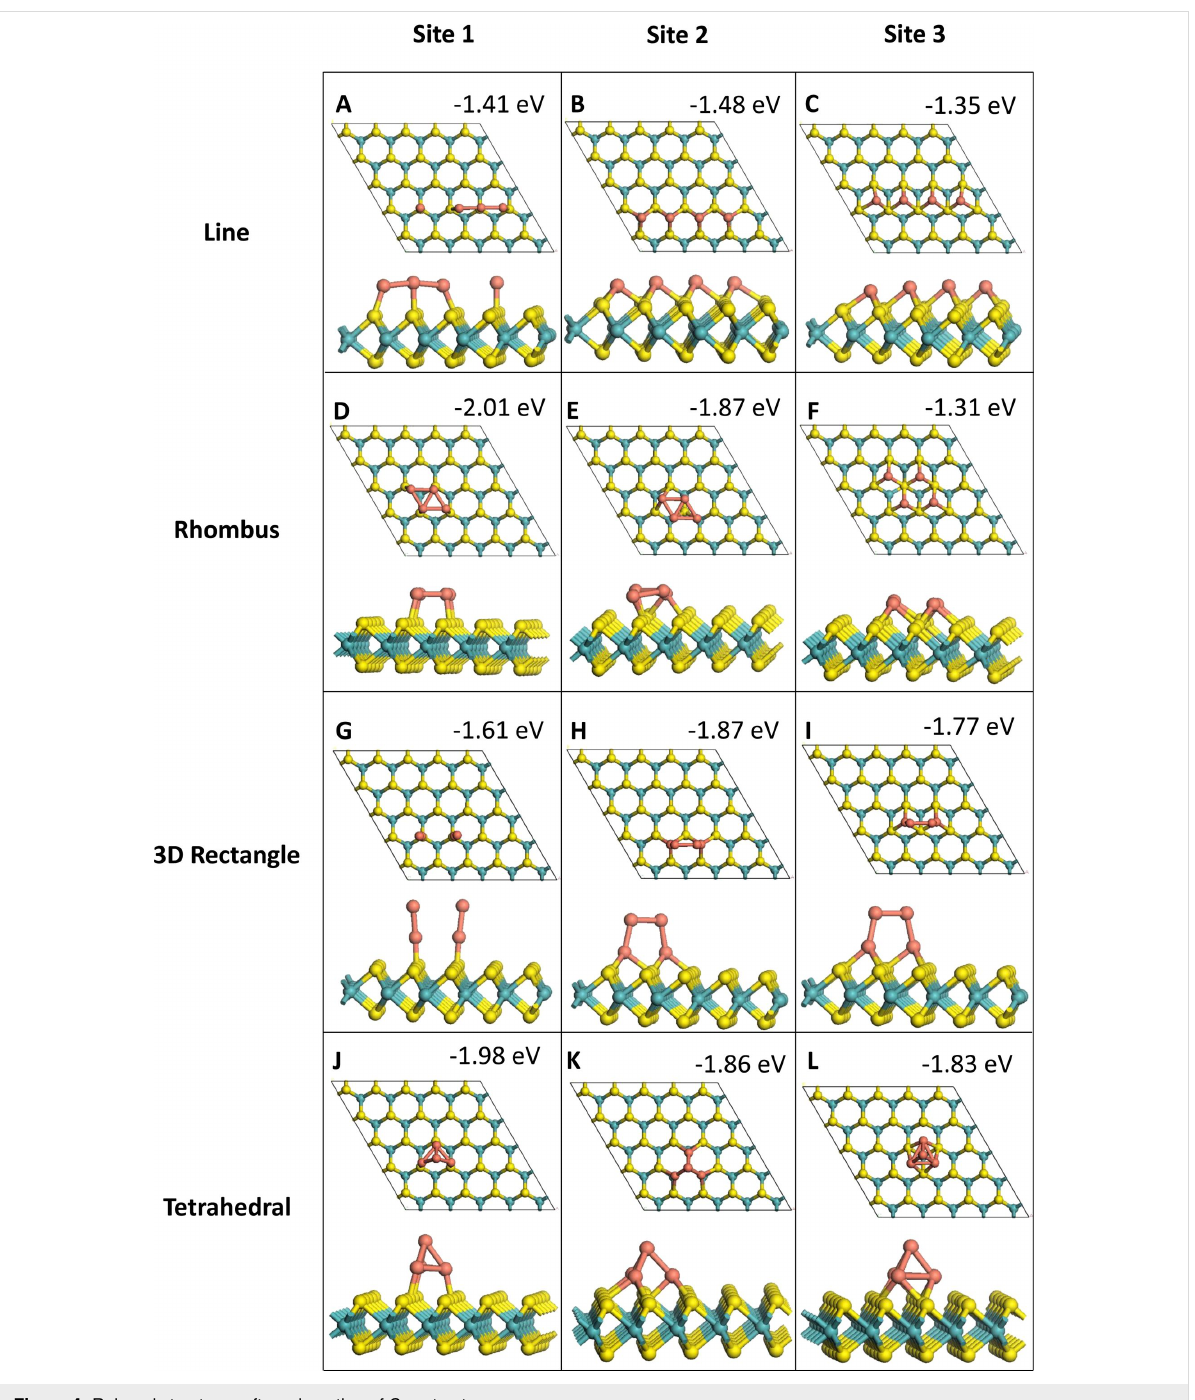
Figure 4: Relaxed structures after adsorption of Cu 4 structures.